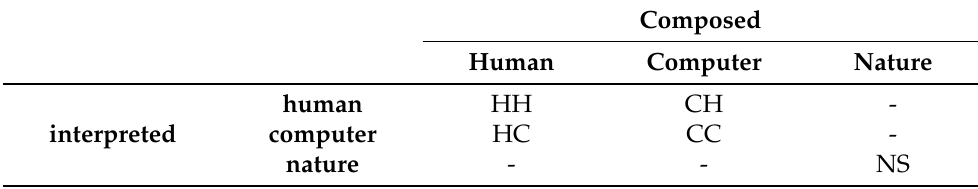
Table 1. Classification of audio samples according to the composer and the interpreter.